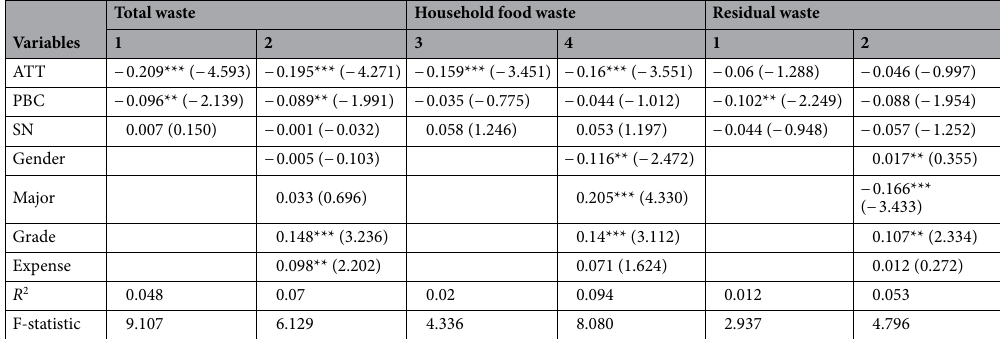
Table 4. Regression results of influencing factors of DSW. Value is the standardized beta coefficients. t statistics in parentheses. ***, ** and * stands for the significance at 1%, 5% and 10% levels respectively. 1–6 refers to different regression models, in which the odd number means the regression does not consider personal attributes’ effect, while the even number means the regression considers.